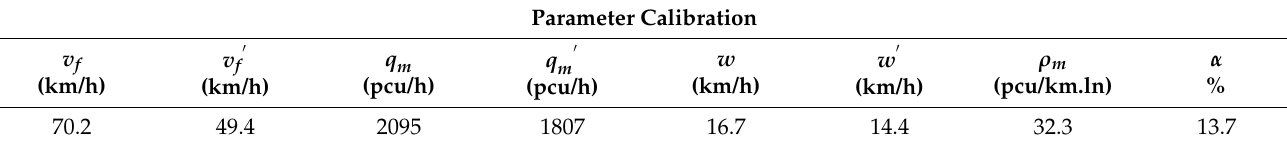
Figure 15. Genetic algorithm iteration. Table 4. Improved CTM parameter calibration results.